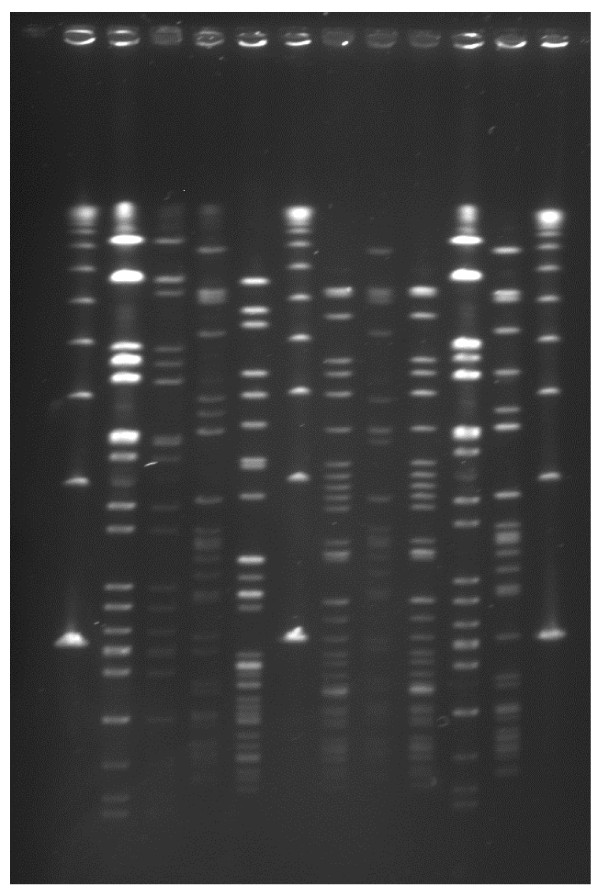
PFGE patterns of sewage sludge samples (from left to right) λ, SL6, SL19, SL25, SL26, λ, SL29, SL34, SL35, SL36, SL47 and λ. λ = Lambda Ladder PFG Marker, DNA size standard (New England BioLabs Inc.) Isolates SL6 and SL36 represent PFGE type 1 and isolates SL29 and SL35 represent PFGE type 4.